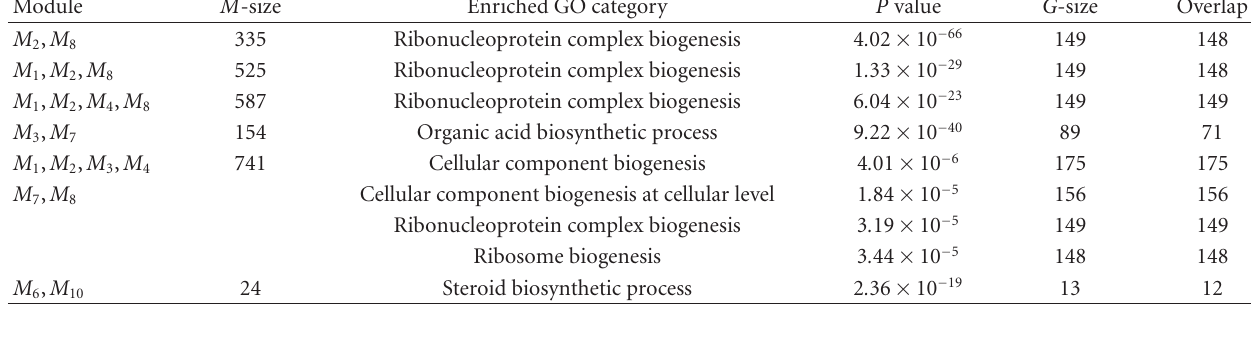
Table 2: GO enrichment analysis results of gene modules on the upper level.